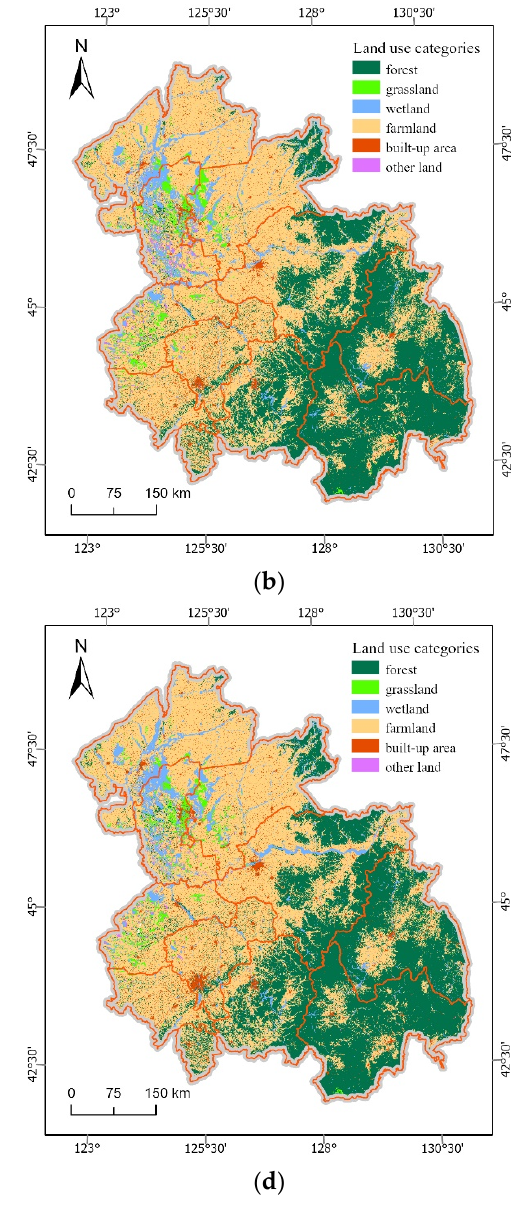
Figure 2. Land use maps in different years: ( a ) 1990; ( b ) 2000; ( c ) 2010; ( d ) 2020.